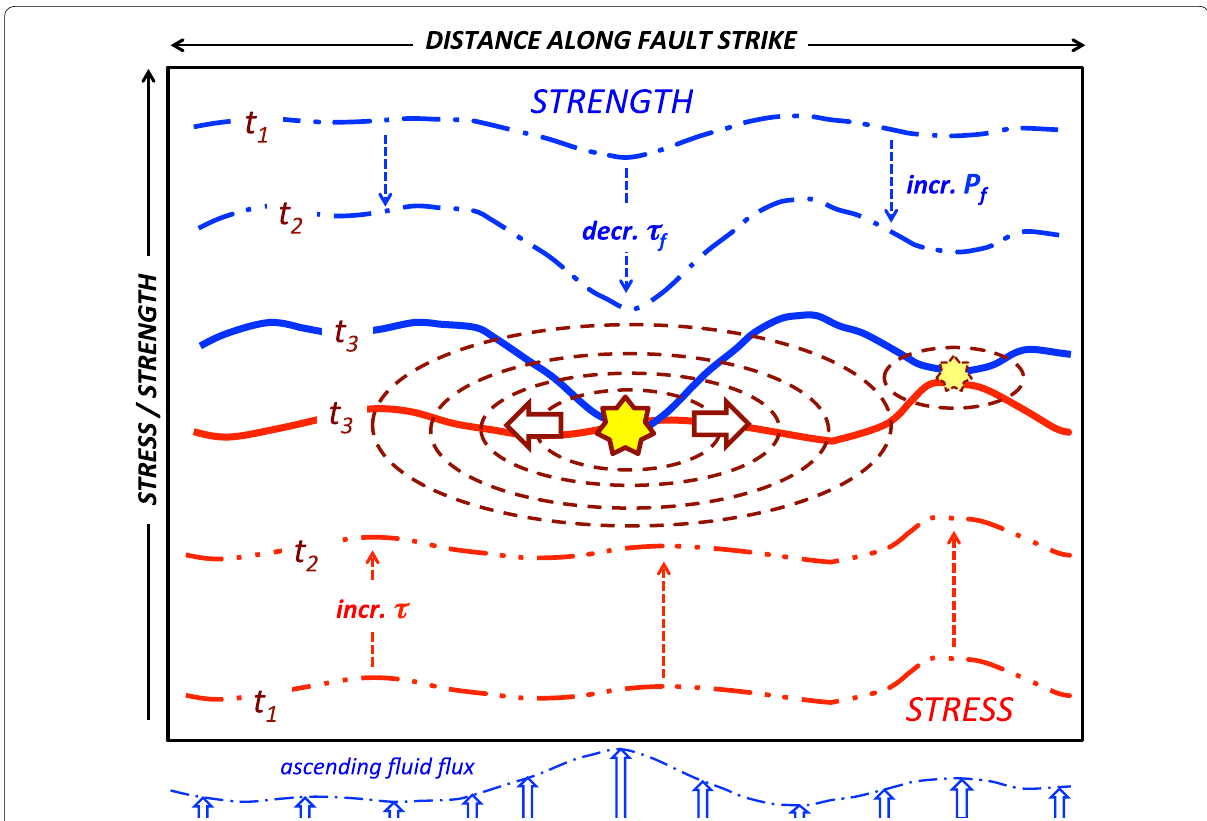
Fig. 12 Schematic illustrating time-varying stress and strength leading to the dual-driven failure of a crustal fault subjected to an ascending overpressured fluid flux at times, t 1 , t 2 , and t 3 (mainshock and aftershock hypocentres denoted by yellow stars; nested ellipses illustrate growth of mainshock rupture) (adapted from Fig. 8 of Sibson